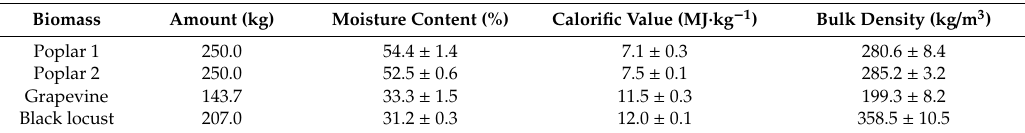
Table 1. Main characteristics of the wood chips (mean ± SD) before drying.